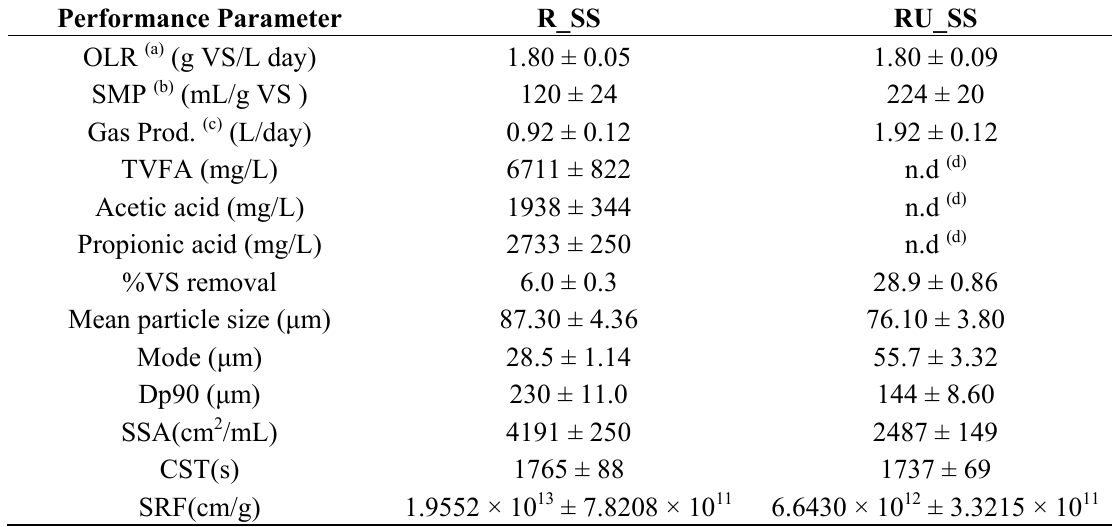
Table 4. Parameters of reactor performance of R_SS and RU_SS operating under semi-continuous